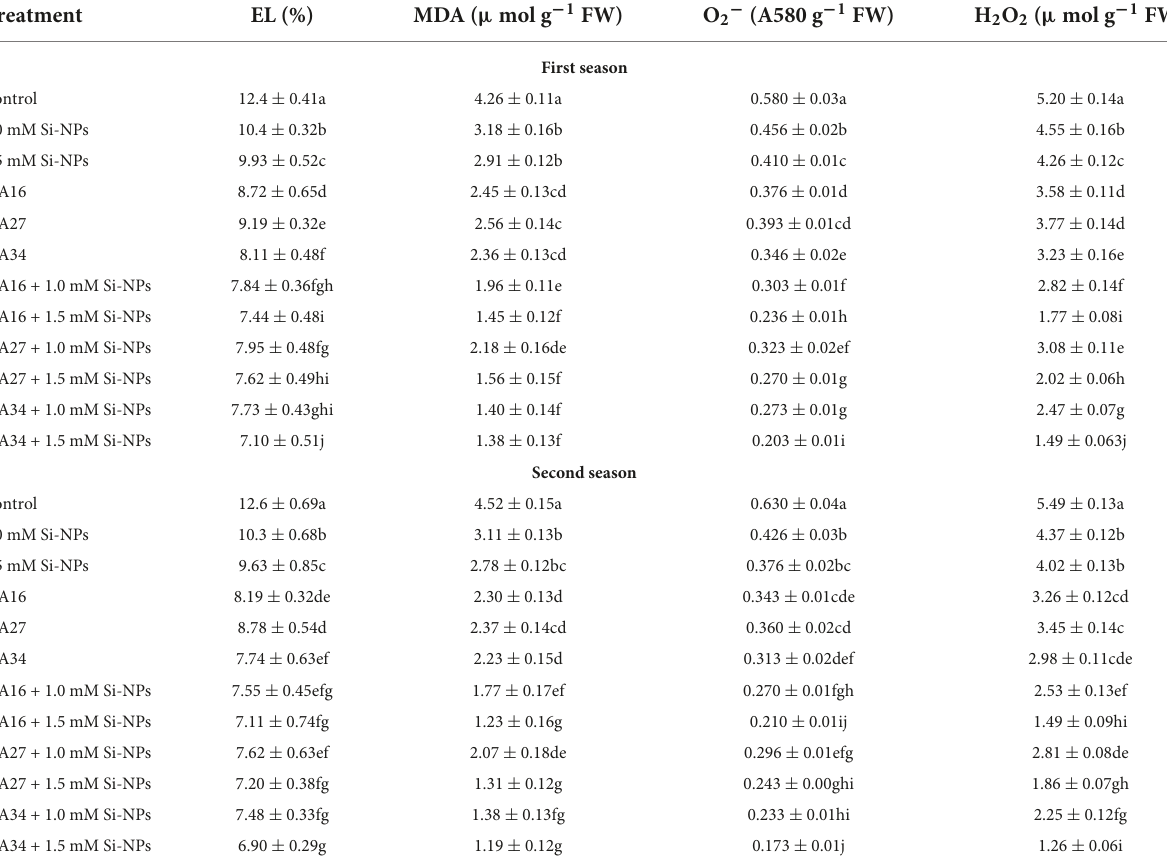
TABLE 5 Effect of soil application with calcium carbonate precipitating bacteria (CCPB), Bacillus lichenforms (MA16), Bacillus megaterium (MA27), and Bacillus subtilis (MA34), and foliar application with silicon nanoparticles (Si-NPs) on oxidative stress of wheat plants (cv. Misr 2).